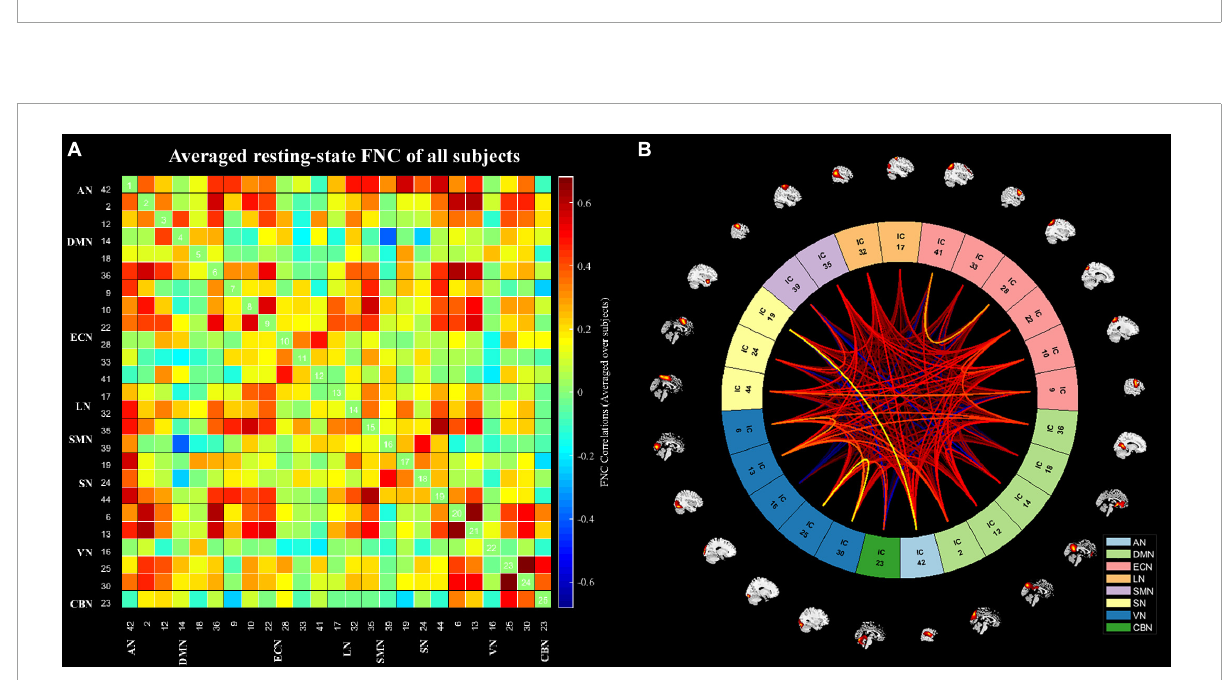
FIGURE1 Spatial independent component analysis was used to identify independent components. Independent component spatial maps divided on eight functional networks (AN, DMN, ECN, LN, SMN, SN, VN, and CBN) based on their anatomical and functional properties. ICA, independent component analysis; AN, auditory network; DMN, default mode network; ECN, executive control network; LN, language network; SMN, sensorimotor network; SN, salience network; VN, visual network; CBN, cerebellar network.